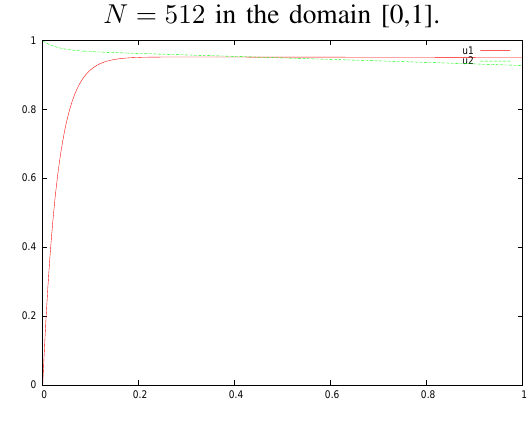
Figure 2. Numerical solution for ε = 2 − 5 and N = 512 in the domain